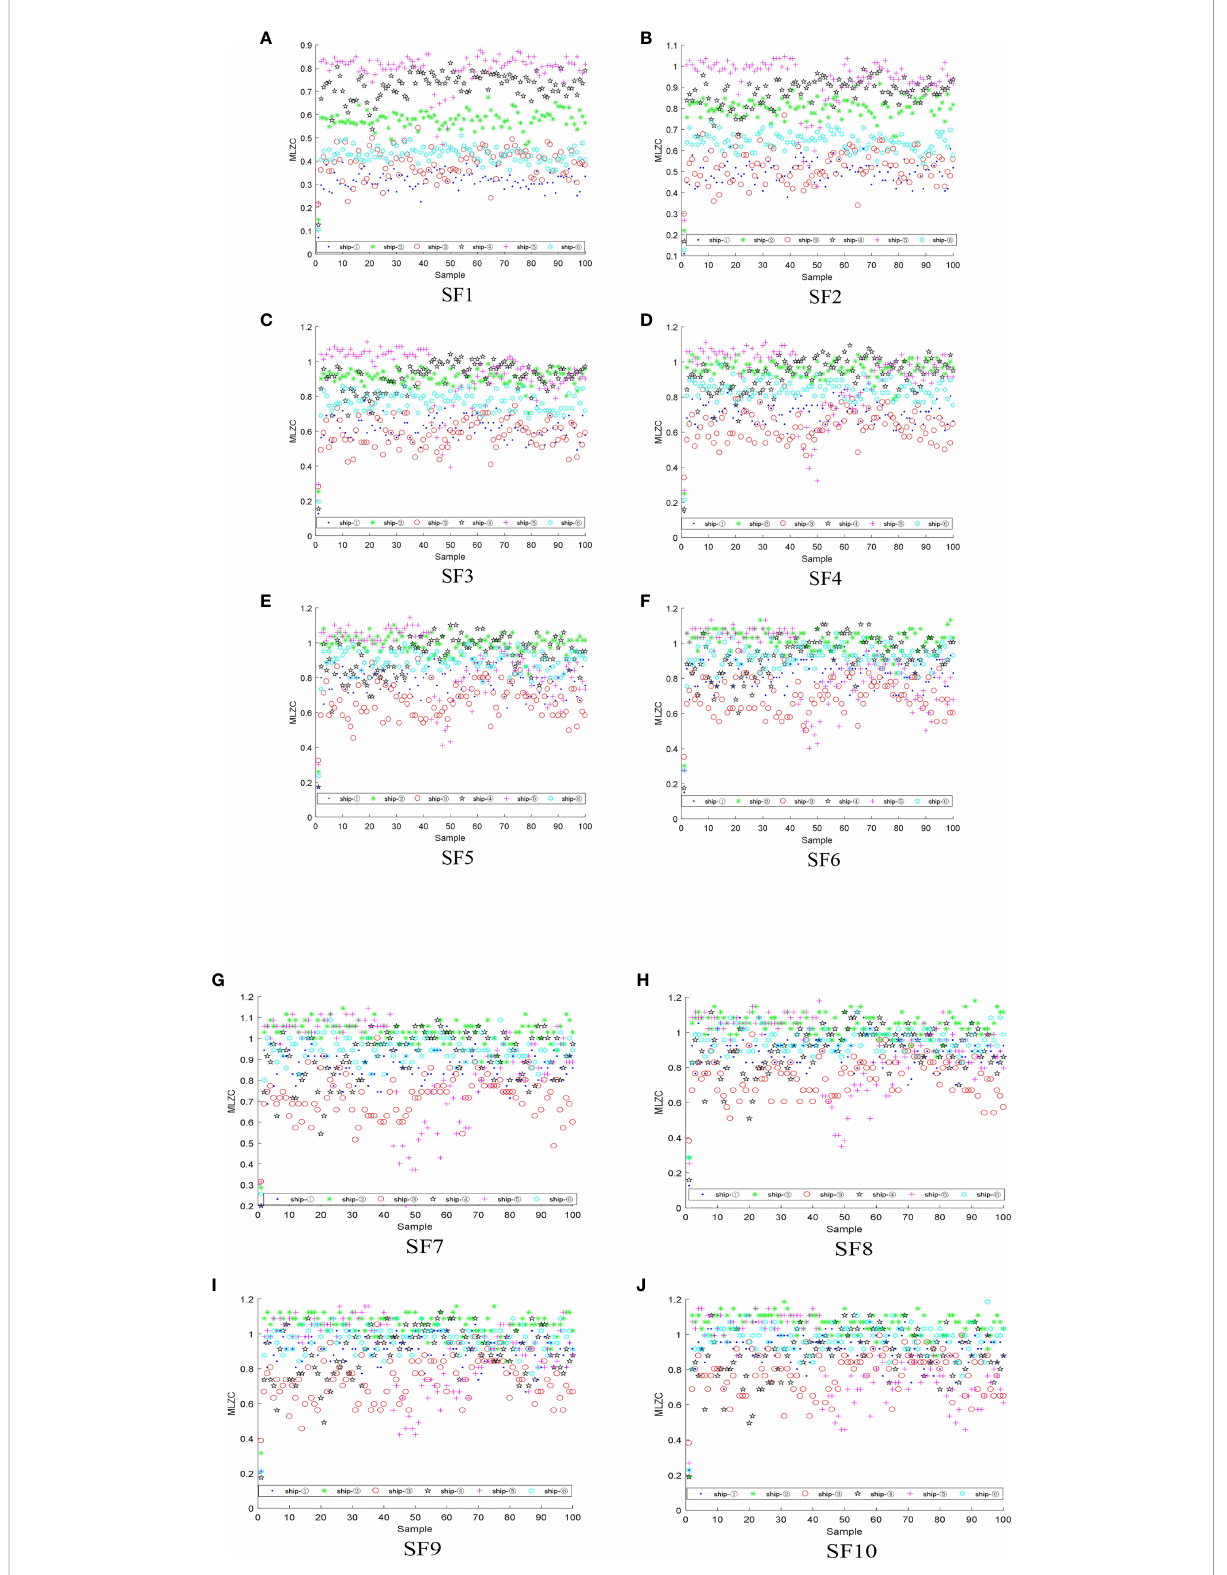
FIGURE 7 The feature distributions of MLZC for six S-Ss under each SF: (A) SF1, (B) SF2, (C) SF3, (D) SF4, (E) SF5, (F) SF6, (G) SF7, (H) SF8, (I) SF9, (J)